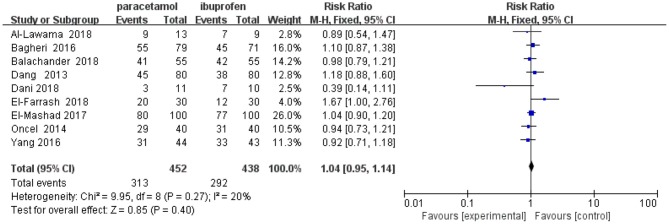
Primary PDA closure.